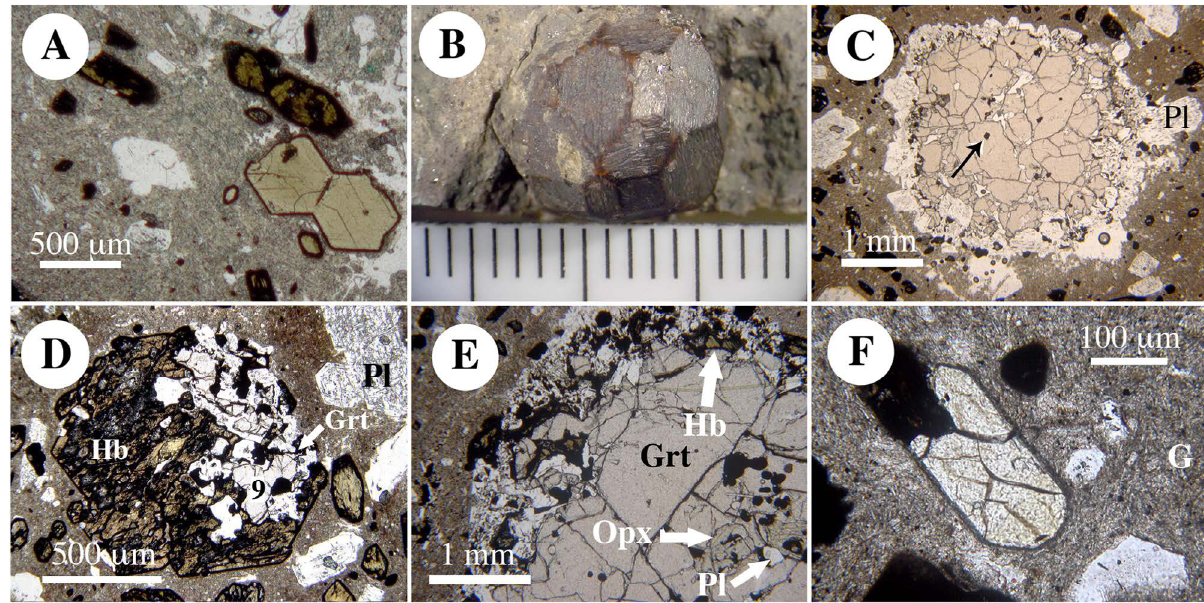
Figure 2: Main mineralogical characteristics of the Breziny garnet-bearing andesite (SK8). Mineral abbreviations after Whitney and Evans [2010]. [A] Microphotograph showing the juxtaposition of two different types of amphi- bole exhibiting various degrees of decomposition into opaque pseudomorphs and hence recording contrasting histories. The green one (lower right corner) is almost devoid of any decompression reaction rim and just exhibits oxidation effect (black rim). Brown crystals, on the contrary, are partly or almost completely oxidised to opacite. Plane-polarised light (PPL). [B] Macrophotograph of a perfectly euhedral garnet megacryst. Scale bar is millimet- ric. [C] Representative example of garnet megacryst with its reaction corona almost exclusively composed of plagioclase. Arrow inside garnet marks ilmenite inclusion (black). PPL. [D] Microphotograph of a euhedral phe- nocryst of brown hornblende with relict garnet inside. Black number in the garnet refers to analysis in Table 6. PPL. [E] Orthopyroxene inclusions in the core of a garnet megacryst whose reaction corona is characterised by brown hornblende. PPL. [F] Rounded microphenocryst of orthopyroxene. G = groundmass.